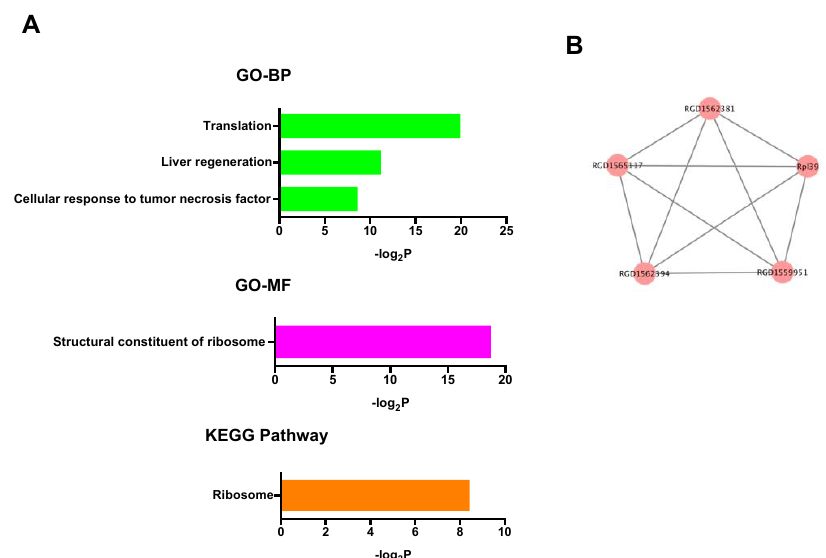
Figure 4. ( A ) GO and KEGG pathway analyses of the up-regulated mRNAs. ( B ) PPI network analysis among the up-regulated mRNAs. Red color node indicates up-regulation. The edges represent the relationships between genes. BP: biological process, GO: gene ontology, KEGG: Kyoto Encyclopedia of Genes and Genomes, MF: molecular function, PPI: protein-protein interaction.